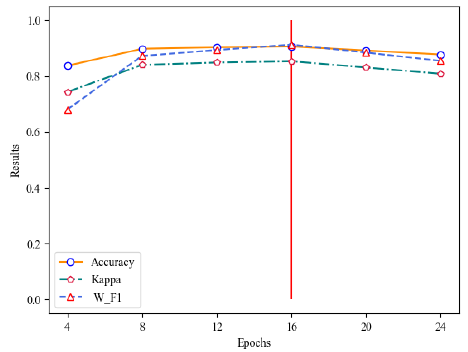
Table 3. Selection of epochs.